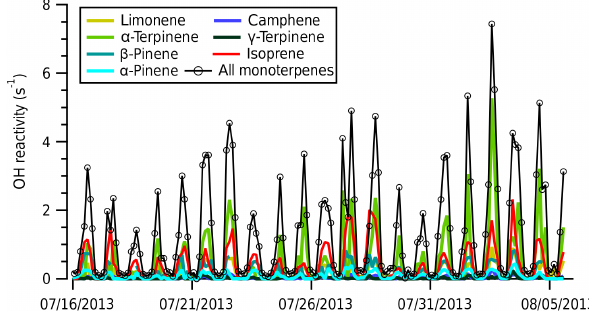
Figure 5. Absolute OH reactivity calculated for the measured bio- genic compounds. Individual compounds’ reactivities were calcu- lated from GC measurements; “all monoterpenes” refers to the summed reactivities of the individual